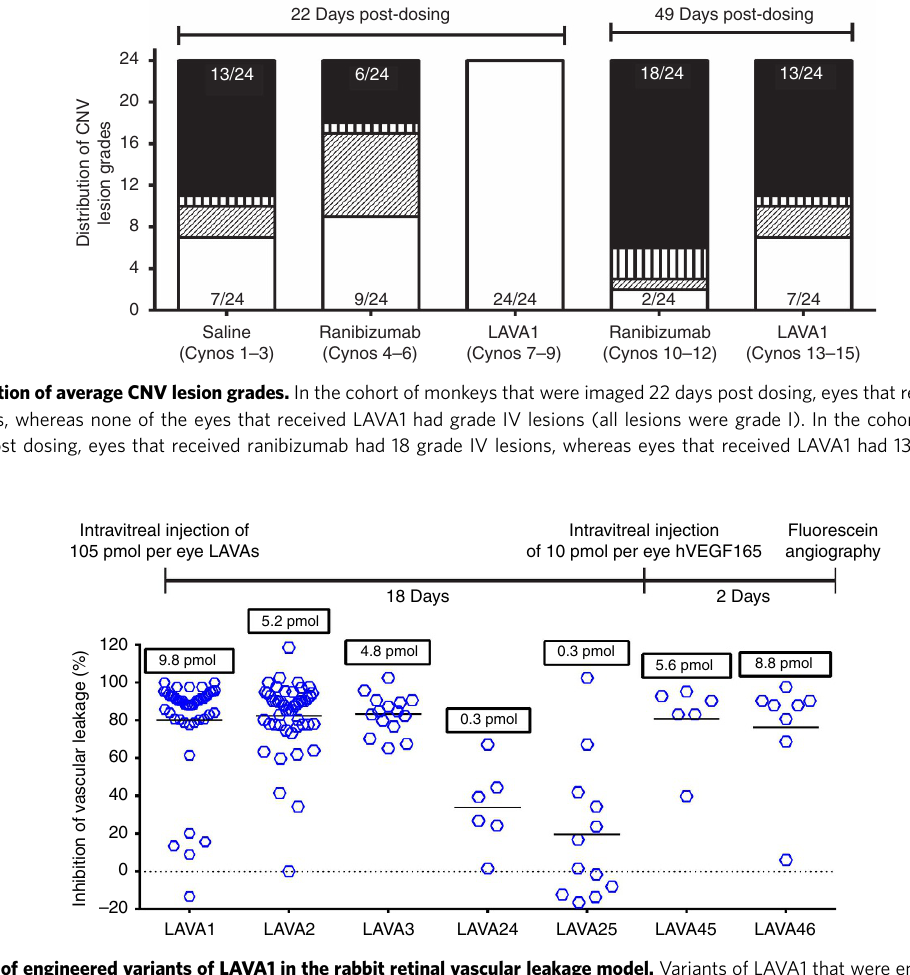
Figure 6 | Efficacy of engineered variants of LAVA1 in the rabbit retinal vascular leakage model. Variants of LAVA1 that were engineered to be resistant to proteolysis (LAVA2, 3, 45 and 46) all potently inhibited fluorescein leakage and had terminal vitreal levels similar to LAVA1 when administered 20 days before fluorescein angiography. In contrast, non-glycosylated variants of LAVA1 (LAVA24 and LAVA25) minimally inhibited fluorescein leakage. The numbers in boxes above the datapoints are the mean terminal drug levels in the vitreous. LAVA24 and LAVA25 had terminal levels that were 39-fold lower than LAVA1. Terminal vitreal levels measured in ng ml (cid:2) 1 were converted to pmoles per eye using a molecular weight of 59kDa for all LAVAs. Vitreal volume in rabbit was assumed to be